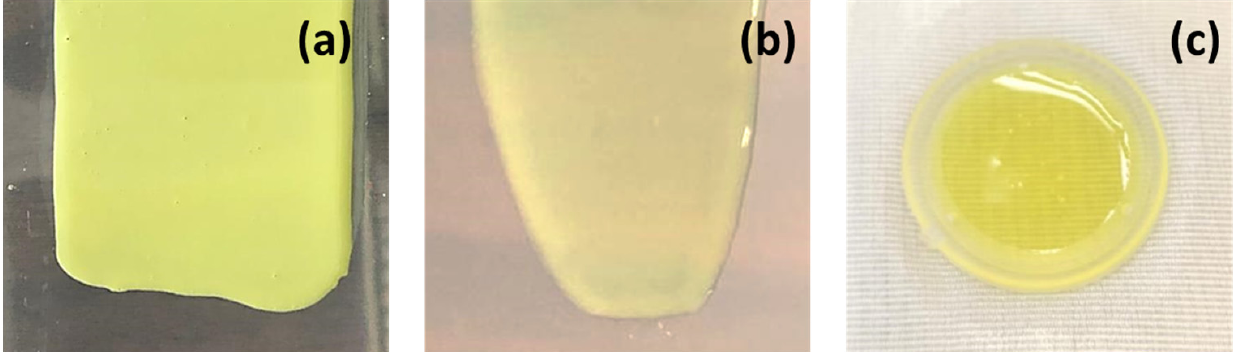
Figure 8. Images of raloxifene loaded in ( a ) a suspension-based PSA TDS, ( b ) a polymer-based TDS, and ( c ) polymeric transdermal gels.